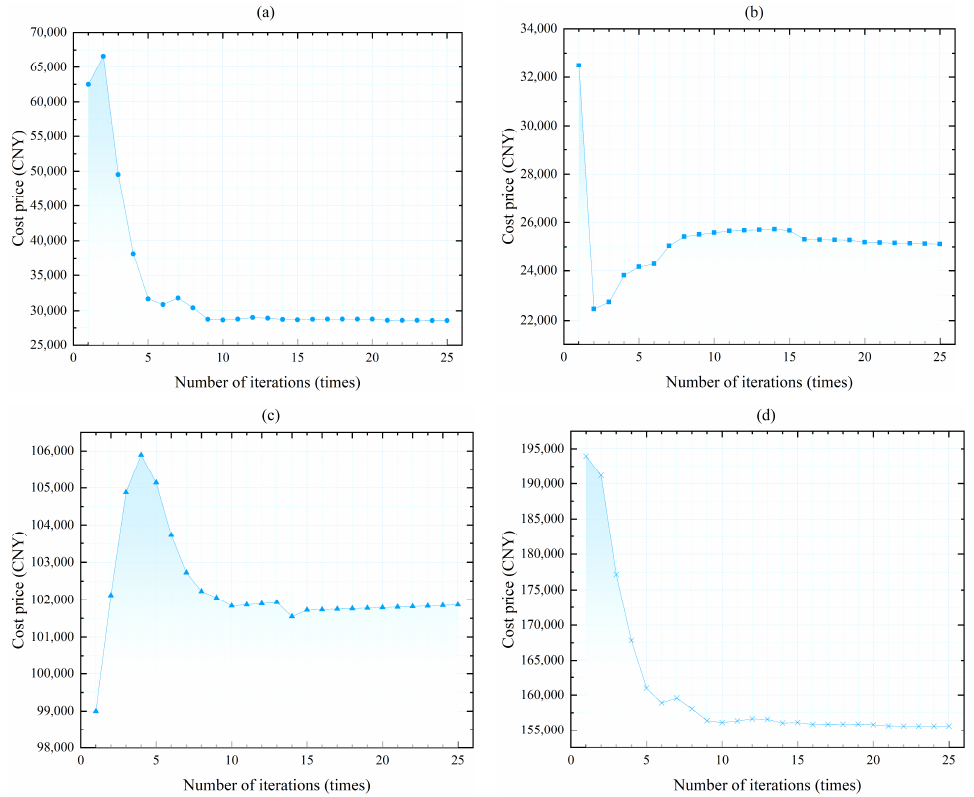
Figure 5. Convergence results of the coalition total running cost of the sub−problem P1 of the lower−level electricity sharing. (a) Iterative result of the micro−grid ① . (b) Iterative result of the micro−grid ② . (c) Iterative result of the micro−grid ③ . (d) Iterated results of the alliance costs.